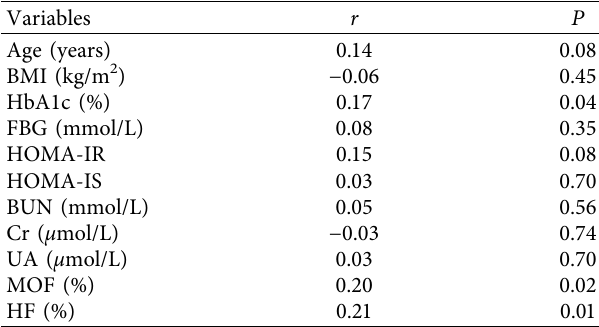
Table 3: Correlations of plasma DPP4 activity and modified FRAX and other clinical parameters in newly diagnosed type 2